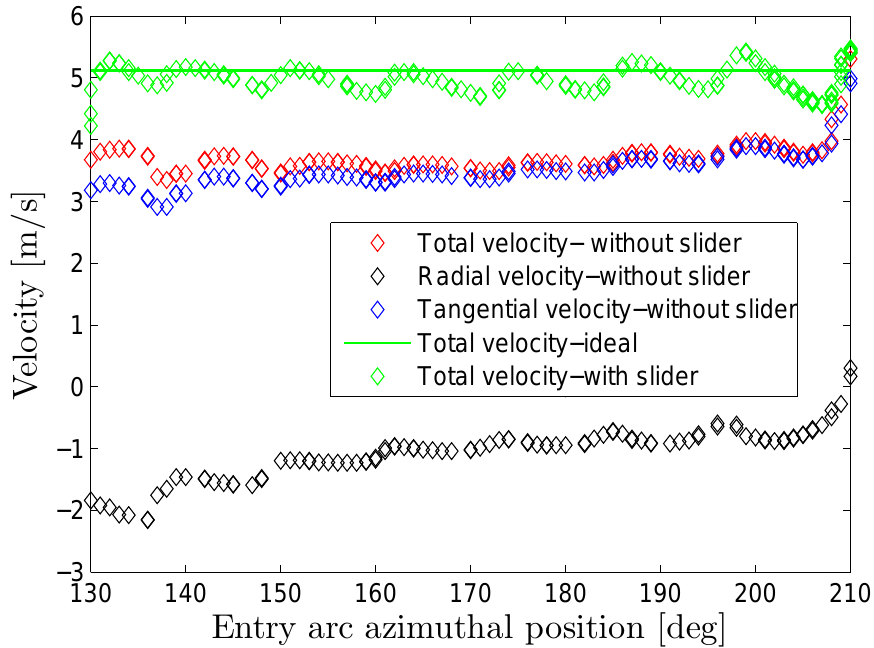
Figure 12. Comparison of runner entry velocities with and without the slider at Q = 40 lps, H = 1.337 m, ω = 199 RPM, and θ s = 78 ◦